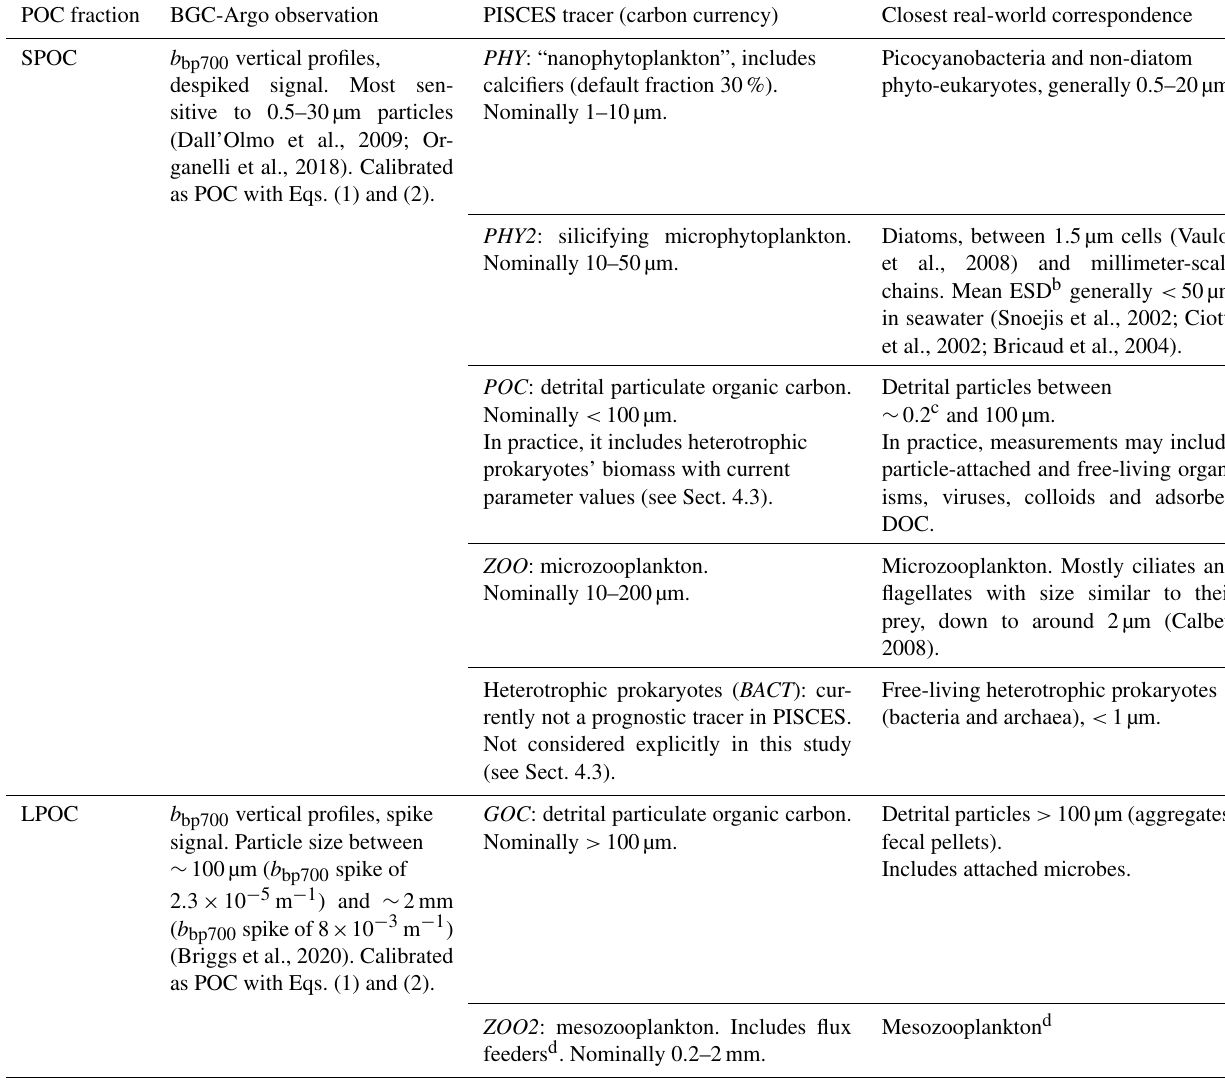
Table 2. Match between BGC-Argo observations, PISCES tracers (Aumont et al., 2017), real-world particulate organic carbon pools, and particle size ranges a